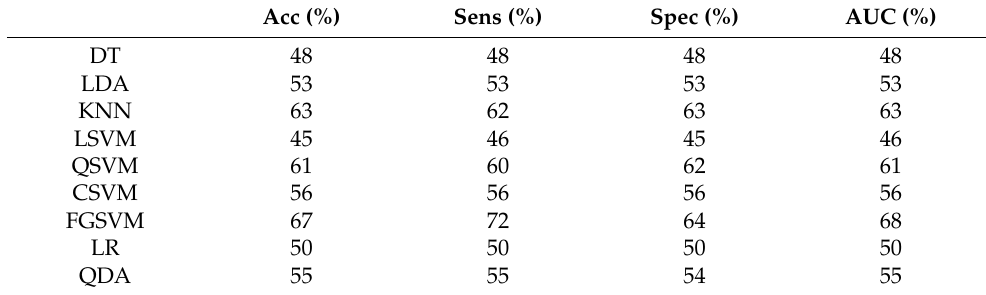
Table 5. Results for the raw data for Dataset